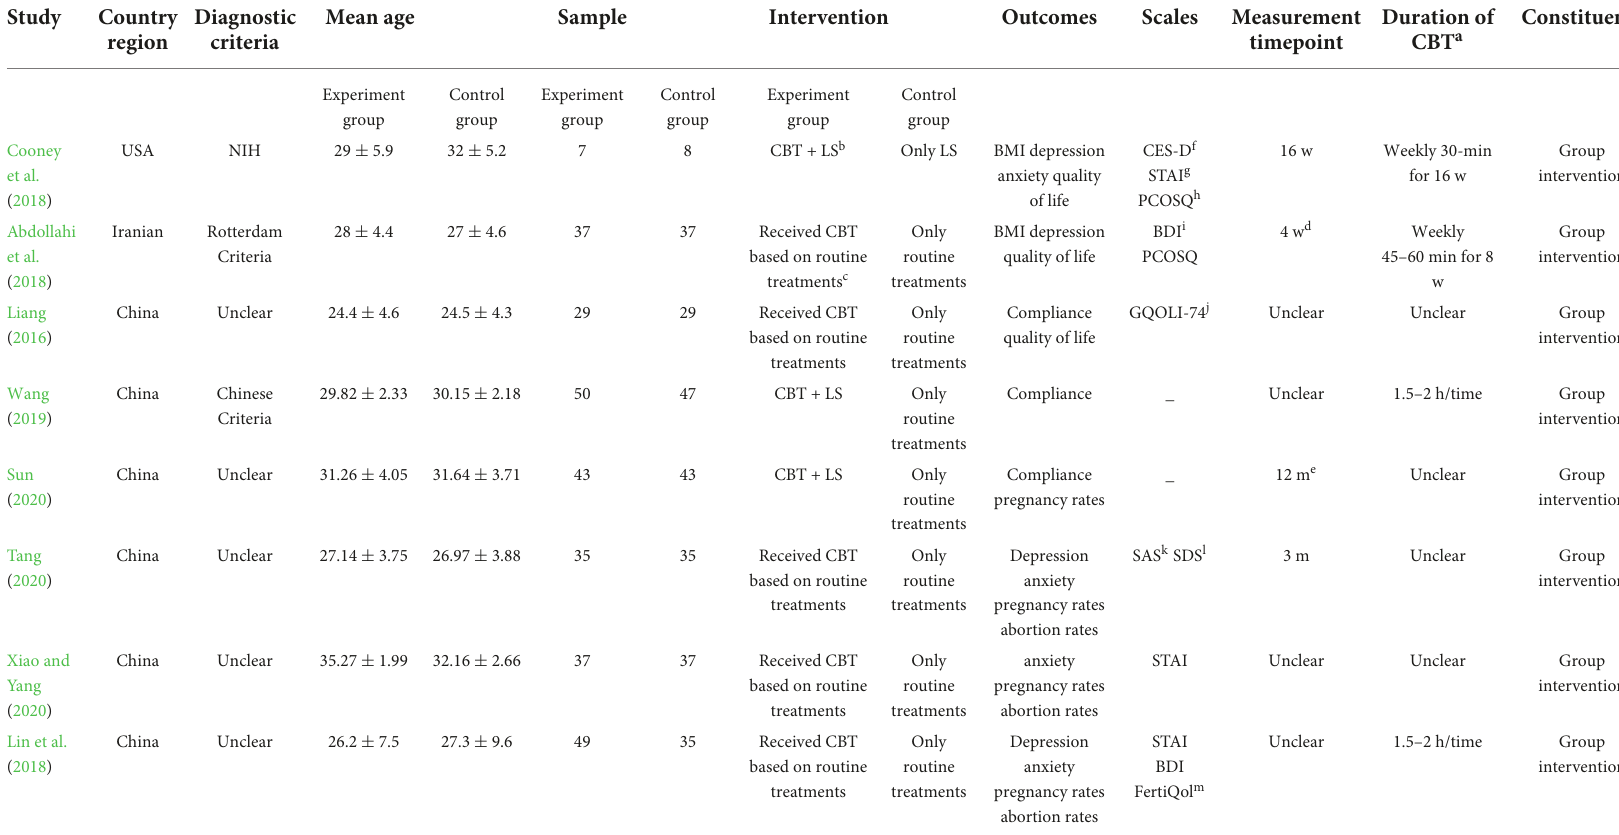
TABLE 1 Characteristics of the included